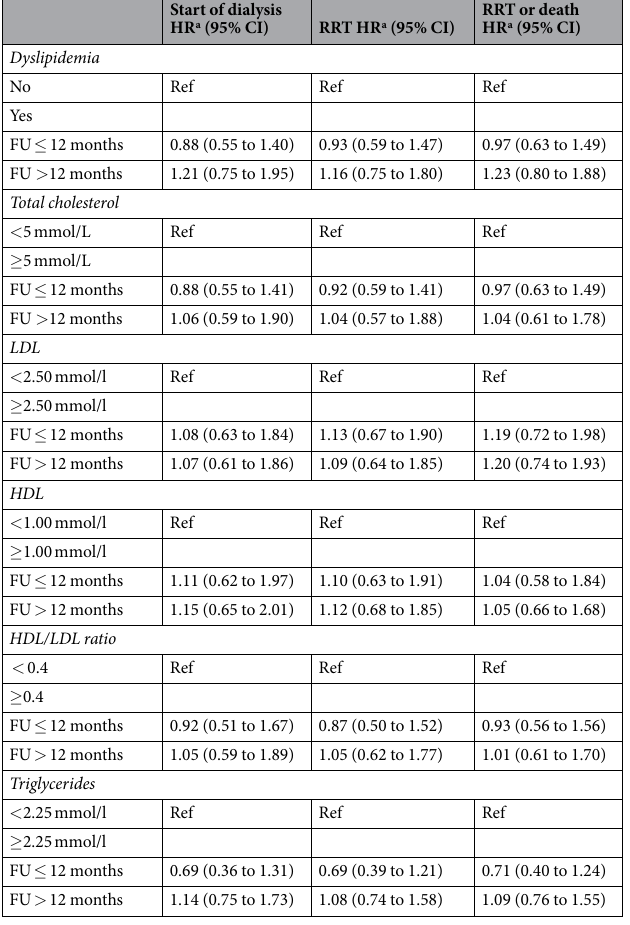
Table 5. Adjusted hazard ratio (95% CI) according to the presence of dyslipidemia, serum lipids or triglycerides category for start of dialysis, RRT and combined endpoint after 12 months and after a minimum of 12 months of follow-up. a All analyses were adjusted for: age, sex, ethnicity, current smoker, body mass index, diabetes mellitus, hypertension, proteinuria and primary kidney disease, CRP, Albumin, Subjective Global Assessment, Lipid-lowering medication use. CI: confidence interval, RRT: Renal Replacement Therapy, FU: